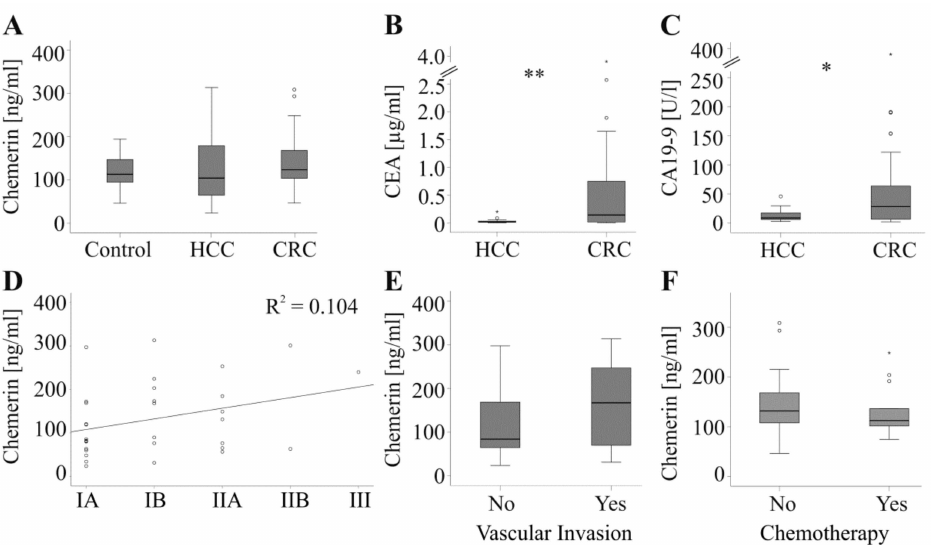
Figure 1. Chemerin and tumor markers. ( A ) Chemerin in serum of 49 controls, 32 patients with hepatocellular carcinoma (HCC) and 36 patients with colorectal carcinoma (CRC). ( B ) CEA in 20 HCC and 32 CRC patients. ( C ) CA19-9 in 19 HCC and 31 CRC patients. ( D ) Correlation of chemerin with TNM stage in HCC patients (TNM stage: IA / IB / IIA / IIB / III, number of patients 14 / 8 / 7 / 2 / 1). ( E ) Chemerin in 20 HCC patients without and 12 HCC patients with vascular invasion. ( F ) Chemerin in 13 CRC patients with and 23 CRC patients without chemotherapy. * p < 0.05, ** p < 0.01.